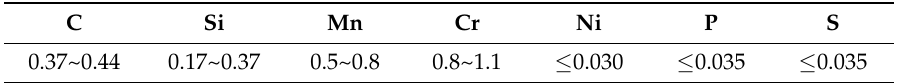
Table 1. The chemical composition of 40Cr steel. Table 2. The mechanical properties of 40Cr